Question: State the chart type depicted above.
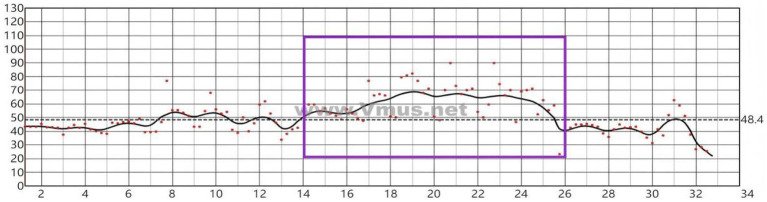
Answer: line